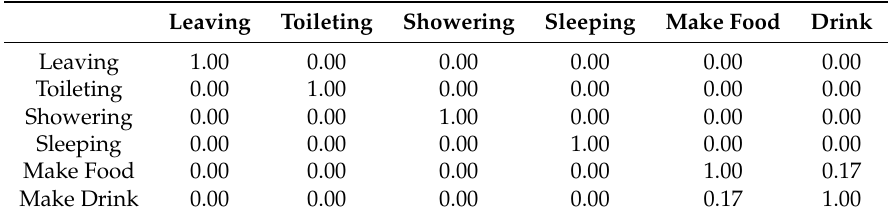
Table 8. Jaccard similarity indices for context descriptors for Kasteren House A.